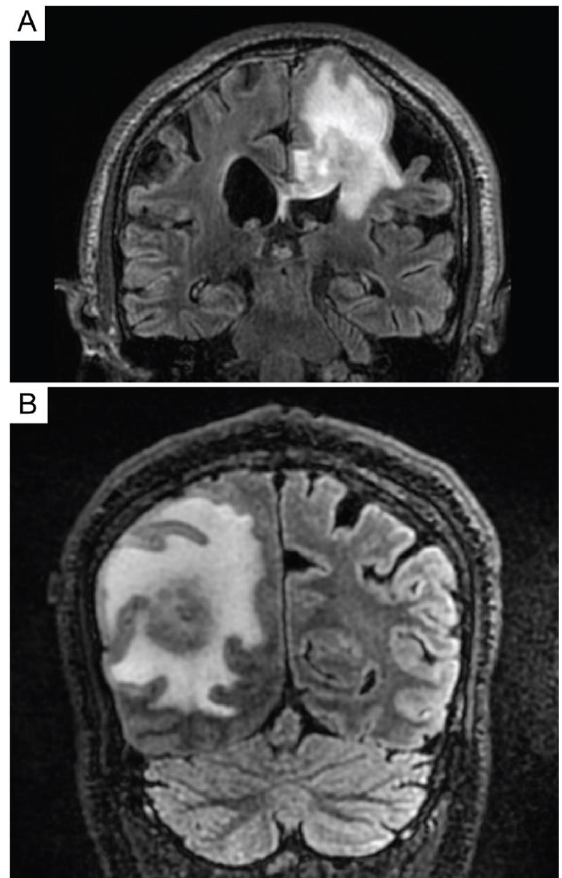
Figure 2. MRI images of a primary central nervous system lymphoma. T2-weighted-Fluid-Attenuated Inversion Recovery (T2-FLAIR) images of patients with primary central nervous system lymphoma that demonstrate T2 hyperintense lesions with increased signal within the surrounding parenchyma.